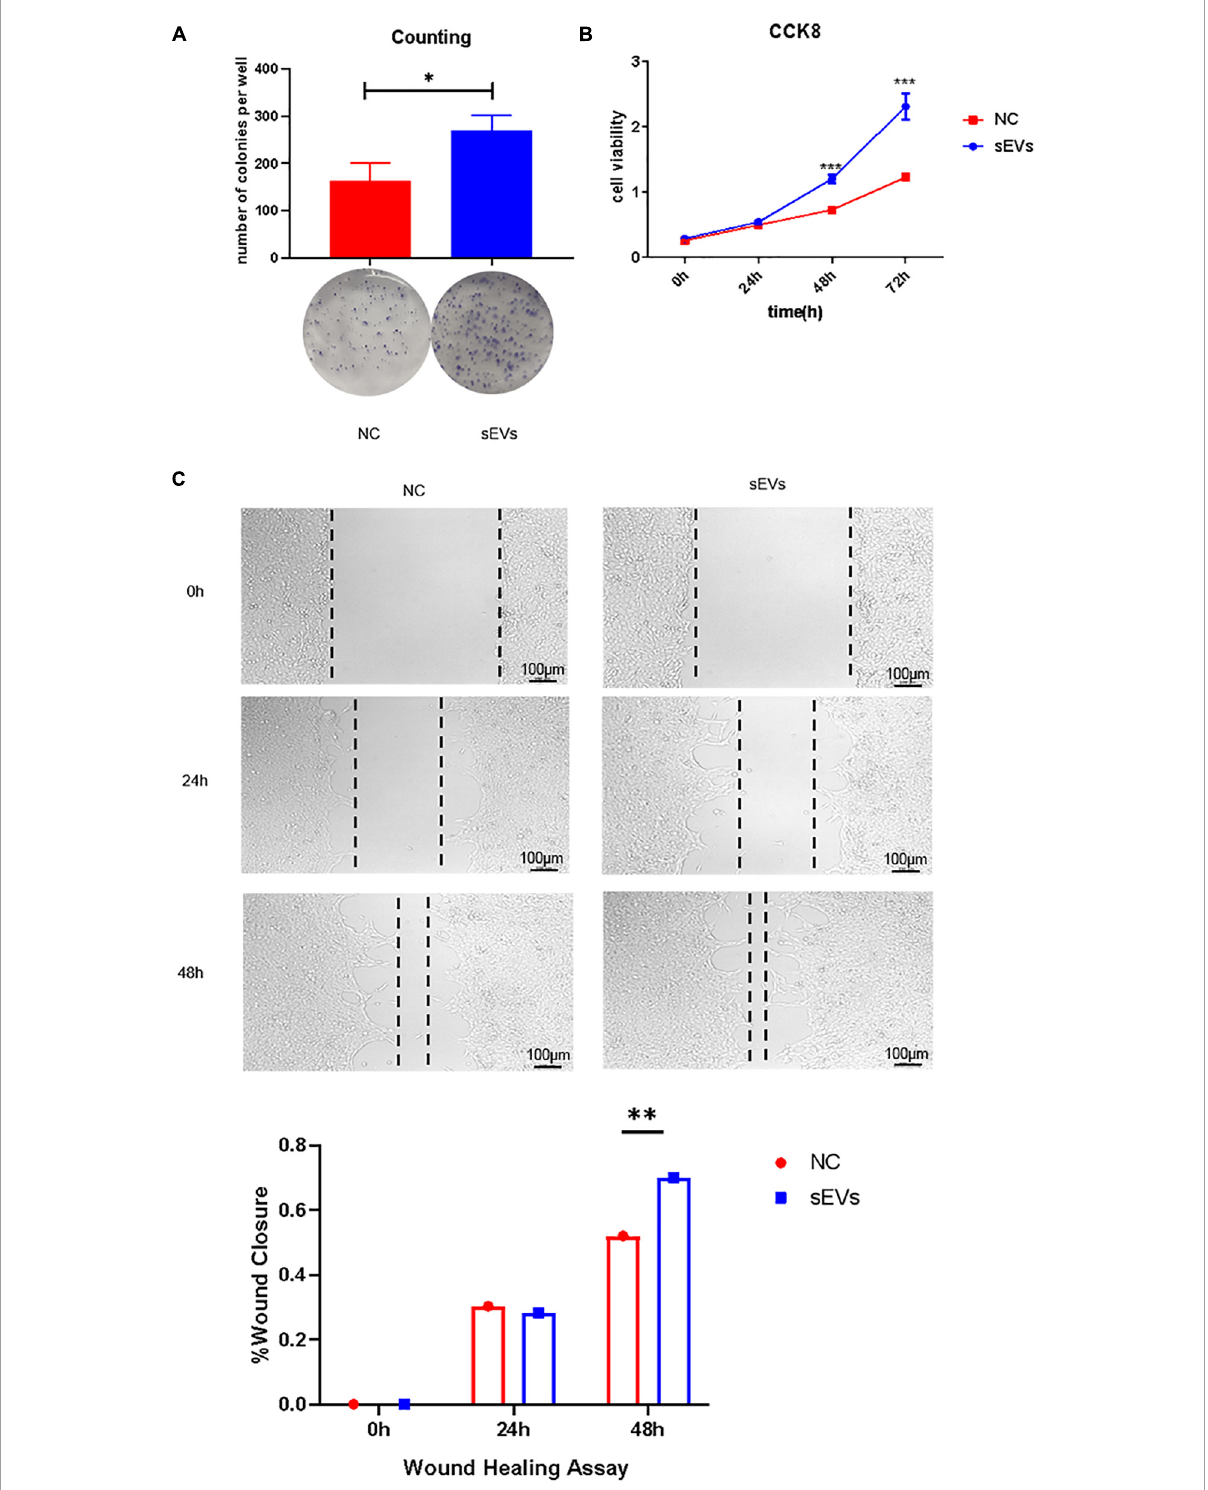
FIGURE3 Protective effect of sEVs derived from hypoxic cultured UC-MSCs against cell damage. (A) Colony formation assay: 700 cells/well were preliminarily grown in a monolayer and irradiated after reaching confluence. The medium was changed daily, and the medium in the experimental group was supplemented with 0.1 mg/ml of hypoxic cultured sEVs. (B) Cell viability assay (CCK-8). (C) Scratch assay. The growth of the experimental and control groups was observed over a 72-h cycle. Statistical significance, p < 0.05. ∗ , ∗∗ , ∗∗∗ Significant